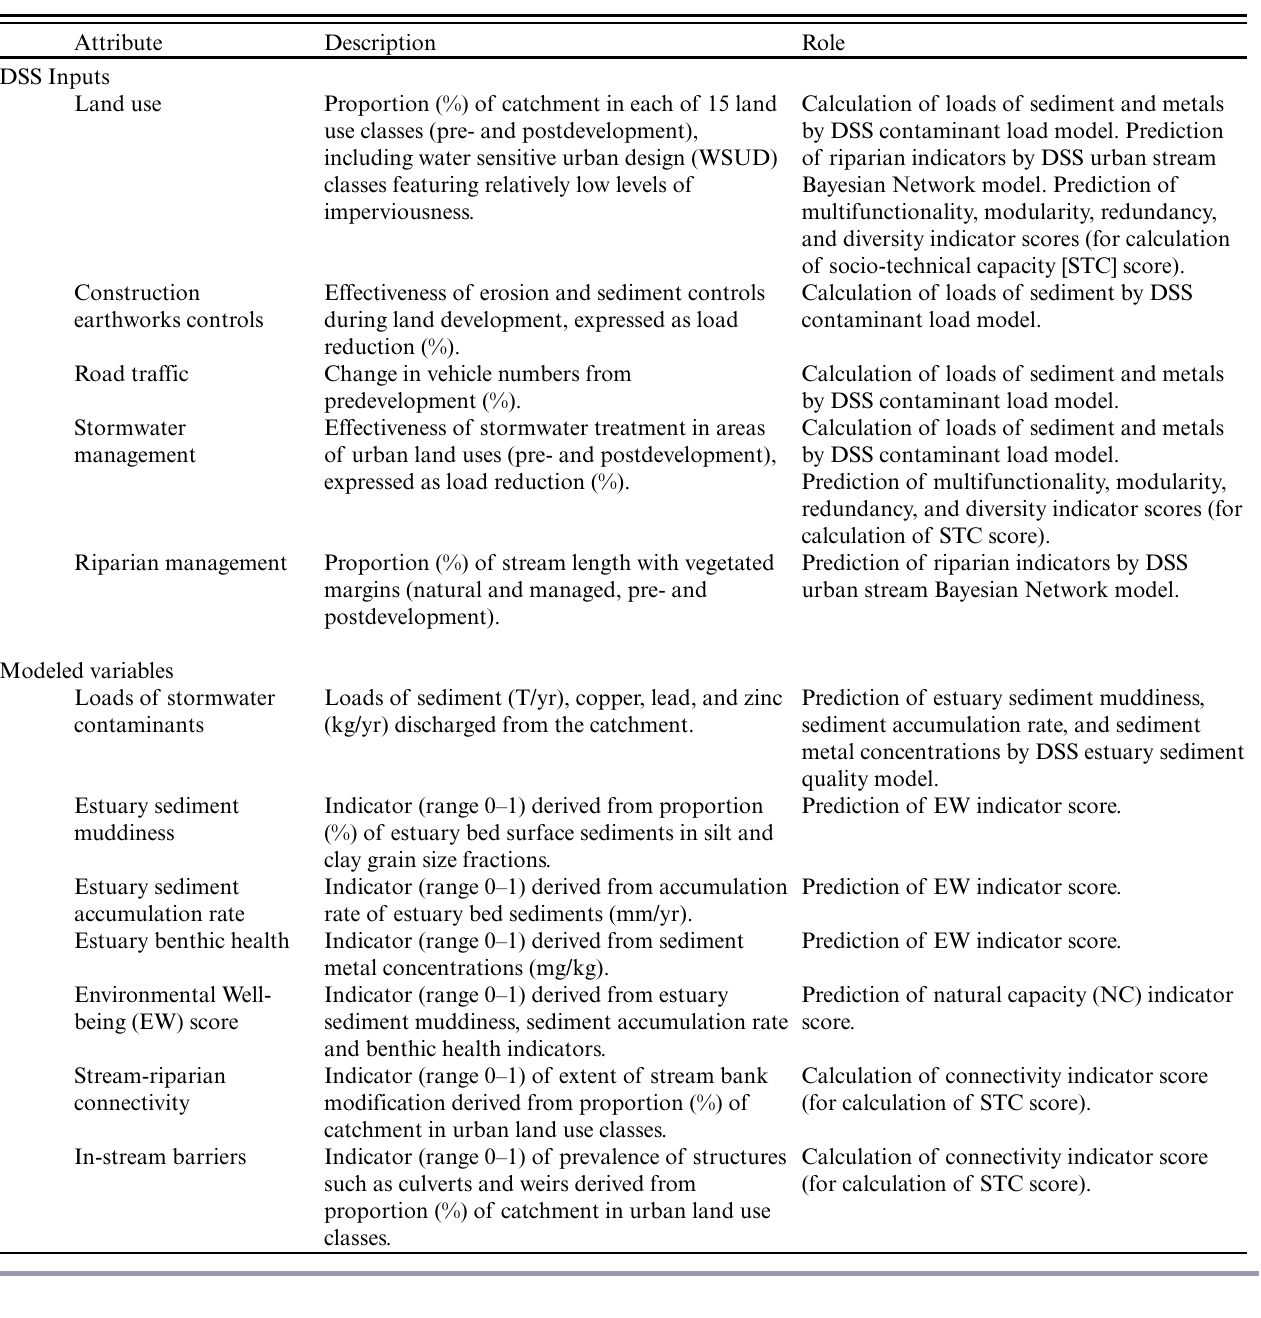
Table 1 . Summary description of decision support system (DSS) inputs and modeled variables involved in the calculation of resilience indicator